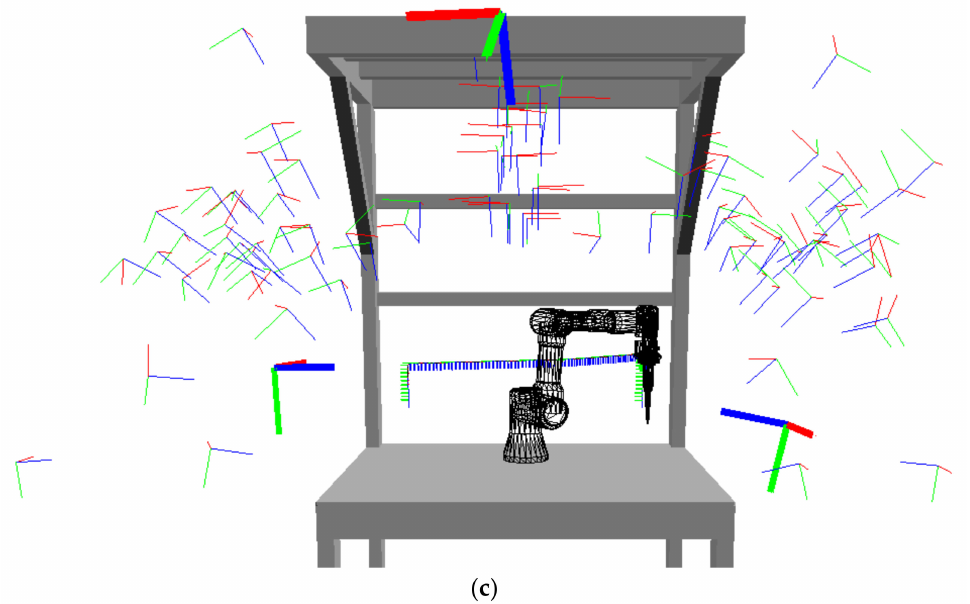
Figure 16. Coordinate systems of proposed camera positions from human subjects (thin lines) and from the automated system (bold lines): ( a ) one camera; ( b ) two cameras; ( c ) three cameras. The comparison of the effectiveness of the camera positions is based on the percentage coverage c rel of the classified voxel grid. The boxplots in Figure 17 show the distribution of c rel values achieved by human subjects, while the red lines represent the c rel values achieved by the automatically placed camera(s).